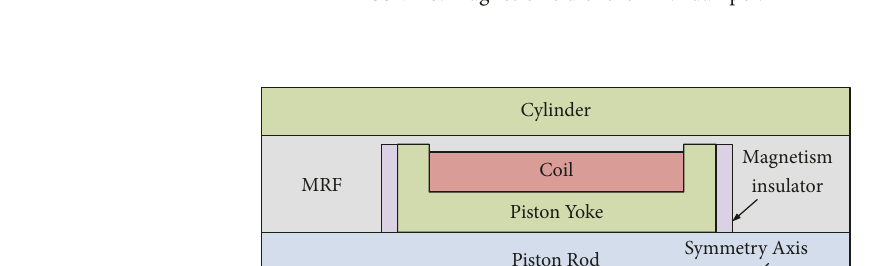
Figure 10: Magnetic field of the MRF damper.